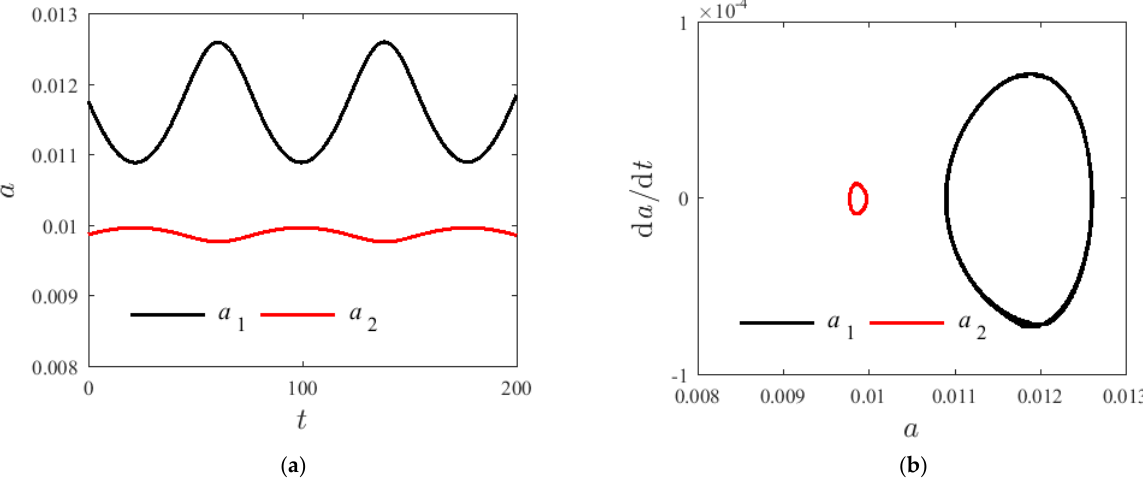
Figure 6. Internal resonances response curves = 50m/s v ; ( a ) time process diagram ( b ) phase diagrams.